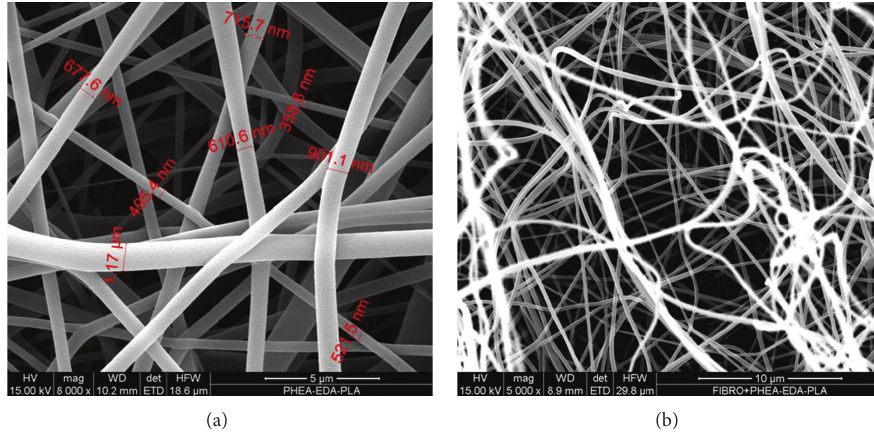
Figure 2: PHEA-PLA-PCL scaffold. (a) SEM, 8000x, (b) SEM,